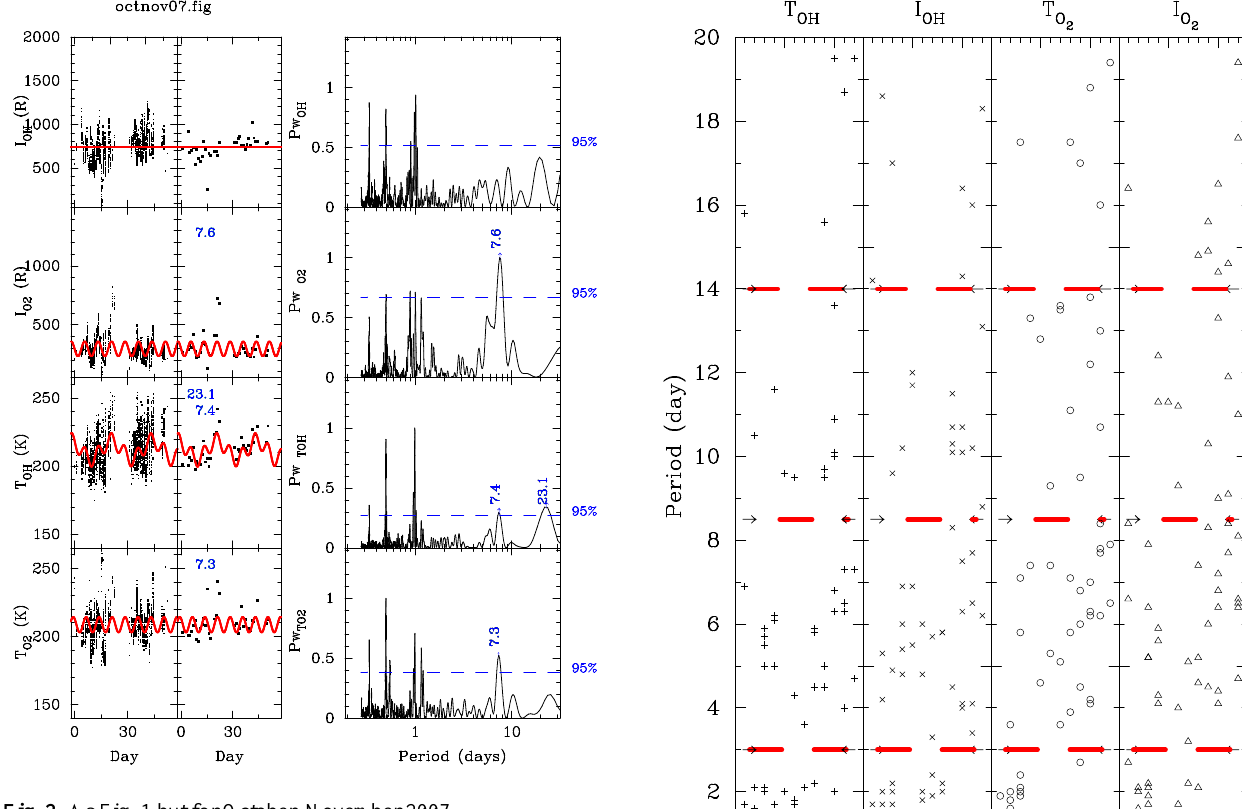
Fig. 2. As Fig. 1 but for October–November 2007.